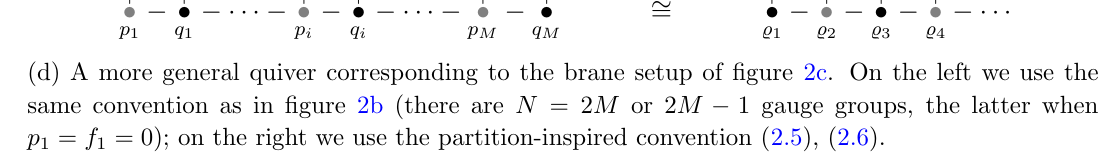
Figure 2. Brane con(cid:12)gurations and quivers for alternating SO-USp gauge and (cid:13)avor groups.